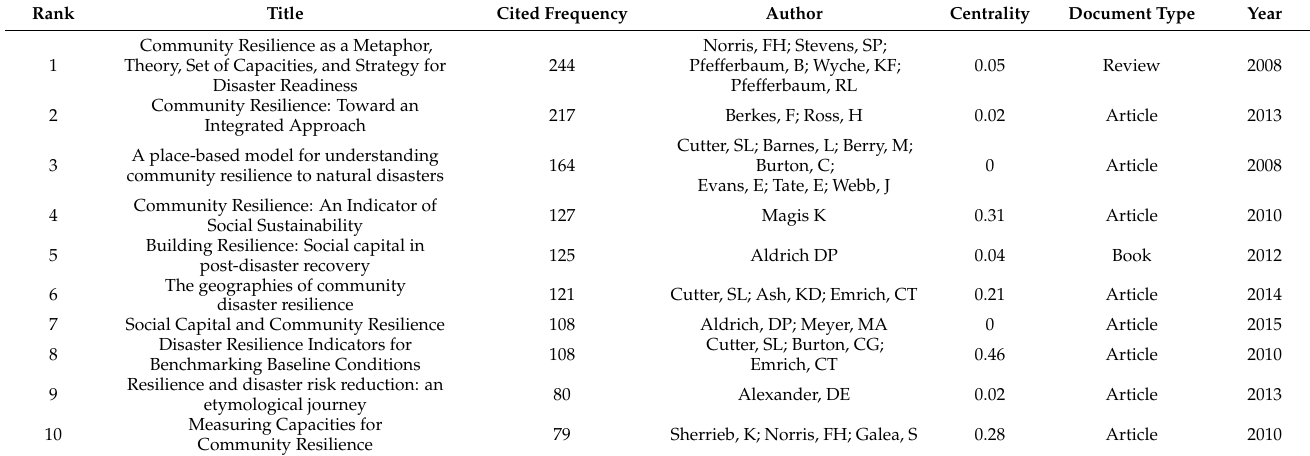
Figure 10. Network visualization map of co-citation documents in community resilience research from 2001 to 2020. Note that nodes refer to citations in data sources, and links represent co-citations between different documents. Table 7. Top 10 highly cited documents in community resilience study from 2001 to